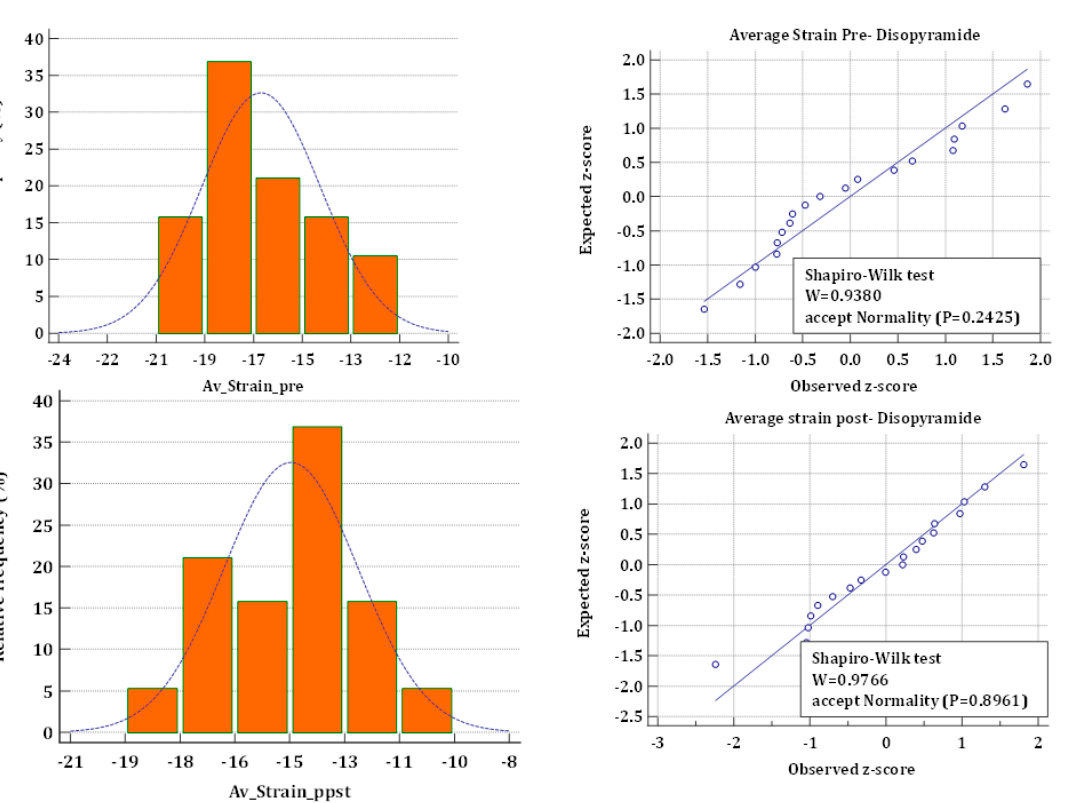
VVI, velocity vector imaging; LVEF, left ventricular ejection fraction; AVC, aortic valve closure; CS, circumferential strain, FEARR, fraction of early apical reverse rotation. Global synchrony is calculated as the fraction of global strain at AVC over the average of peaks of segmental strain.